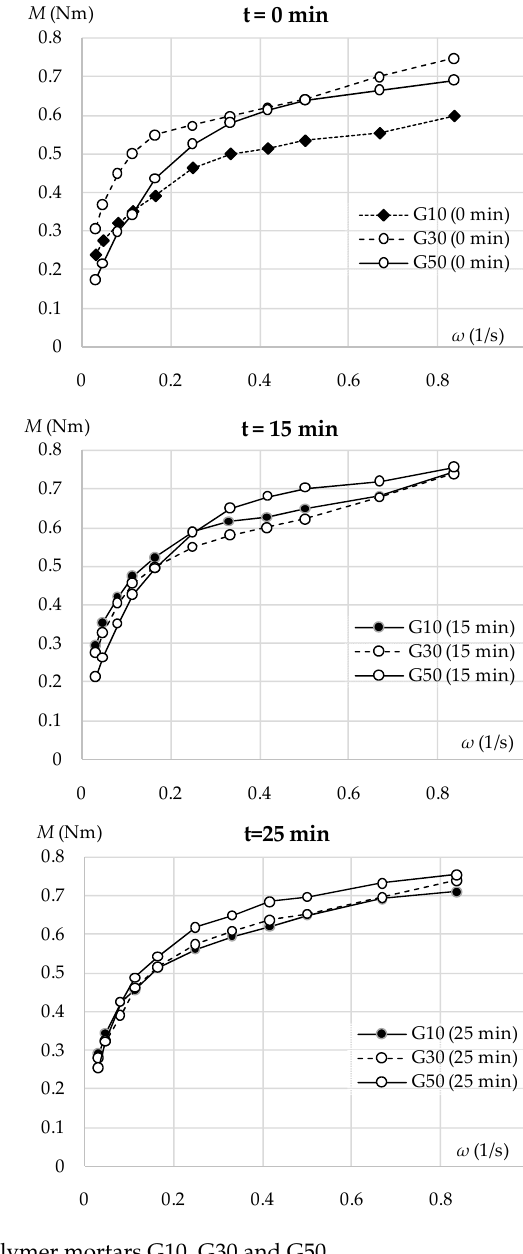
Figure 1. Flow curves for geopolymer mortars G10, G30 and G50.